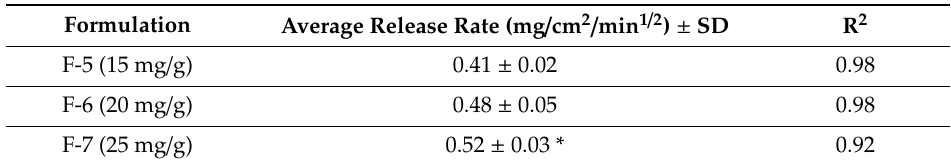
Table 6. In vitro drug release rate ang goodness of fit of ACTH ointments using Higuchi’s model ( n = 6); *— p < 0.05.